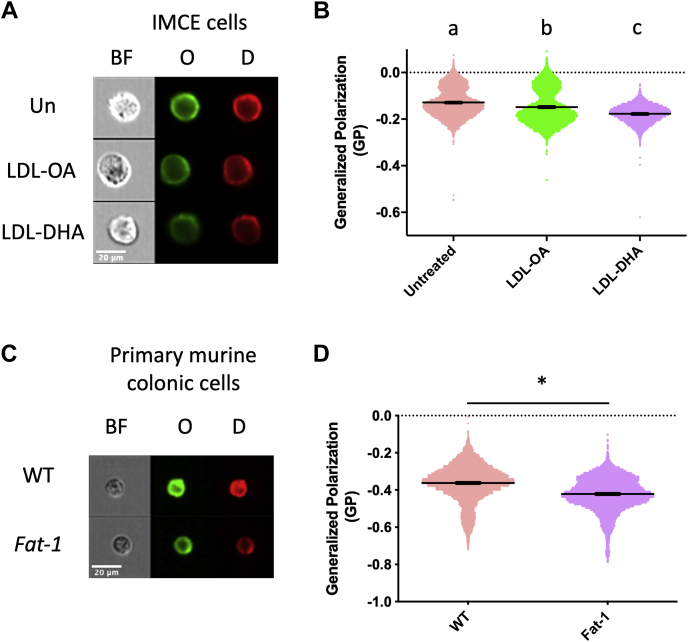
DHA reduces plasma membrane rigidity. IMCE cells were incubated with the indicated treatments (50 μM) for 24 h before labeling with Di-4-ANEPPDHQ, followed by assessment of membrane order using imaged based flow cytometry. A: Representative images and (B) quantitative analysis of membrane order in IMCE cells. Data represent mean ± SE from individual cells from untreated (13,240), LDL-OA (12,202), and LDL-DHA (14,674), from three independent experiments. Statistical significance between treatments as indicated by uncommon letters (P < 0.0001) was examined using one-way ANOVA and uncorrected Fisher's LSD tests. Single cells from wild-type or Fat-1 mice were labeled with Di-4-ANEPPDHQ and imaged via imaging flow cytometry. C: Representative images and (D) quantitative analysis of membrane order in isolated primary murine colonic cells. Data represent mean ± SE from individual cells from WT (12,655) and Fat-1 (16,675) from 3 and 4 mice, respectively. Statistical significance between groups (∗P < 0.0001) was examined using an unpaired t-tests.